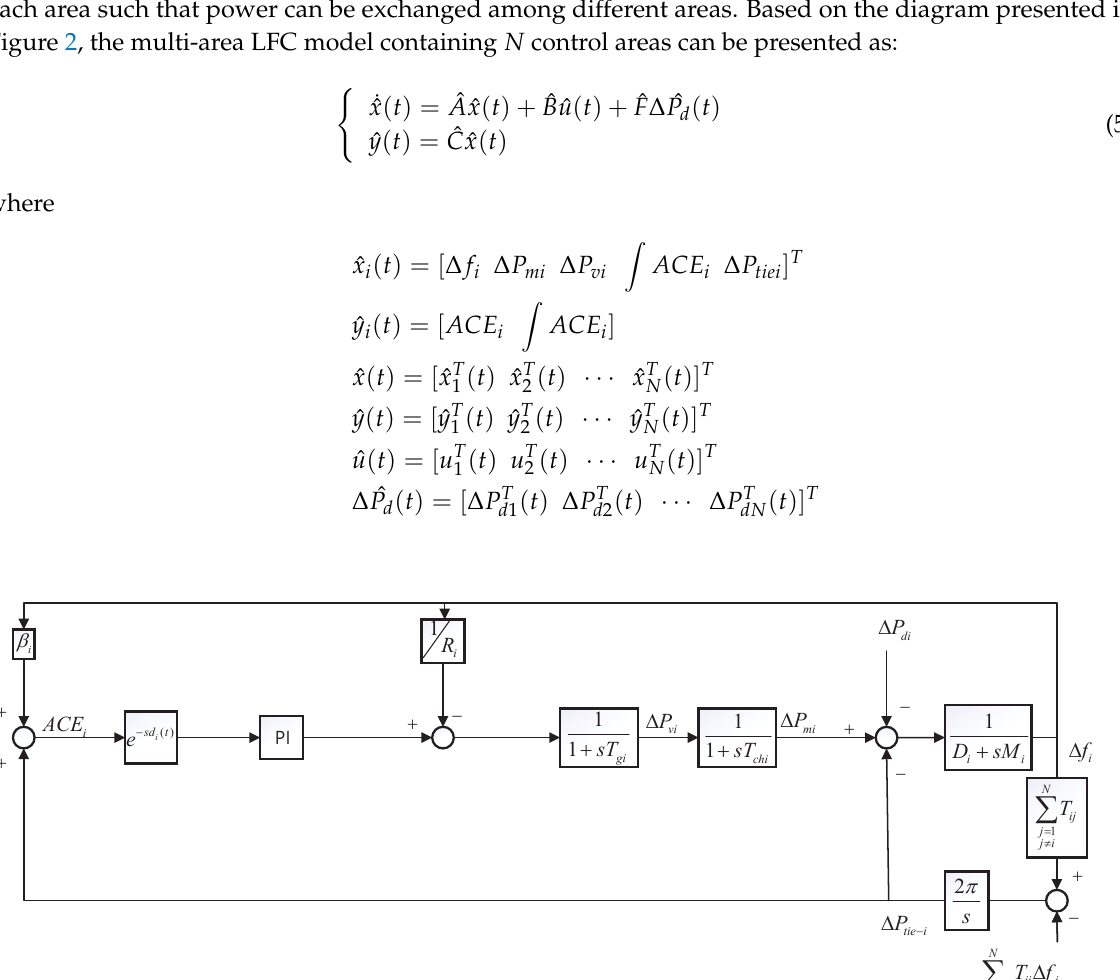
Figure 2. Control area i of the multi-area LFC